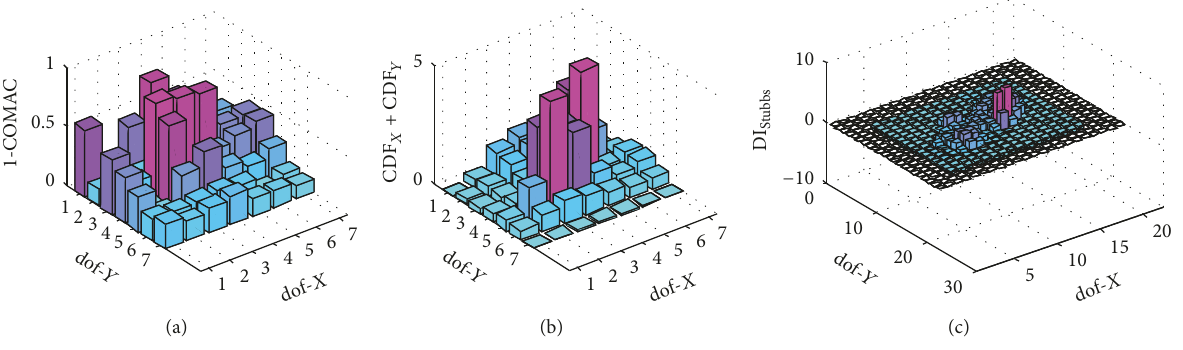
Figure 7: Damage indicators calculated for DS3 versus DS0 for a 49-dof model. (a) COMAC, (b) CDF, and (c) DI Stubbs